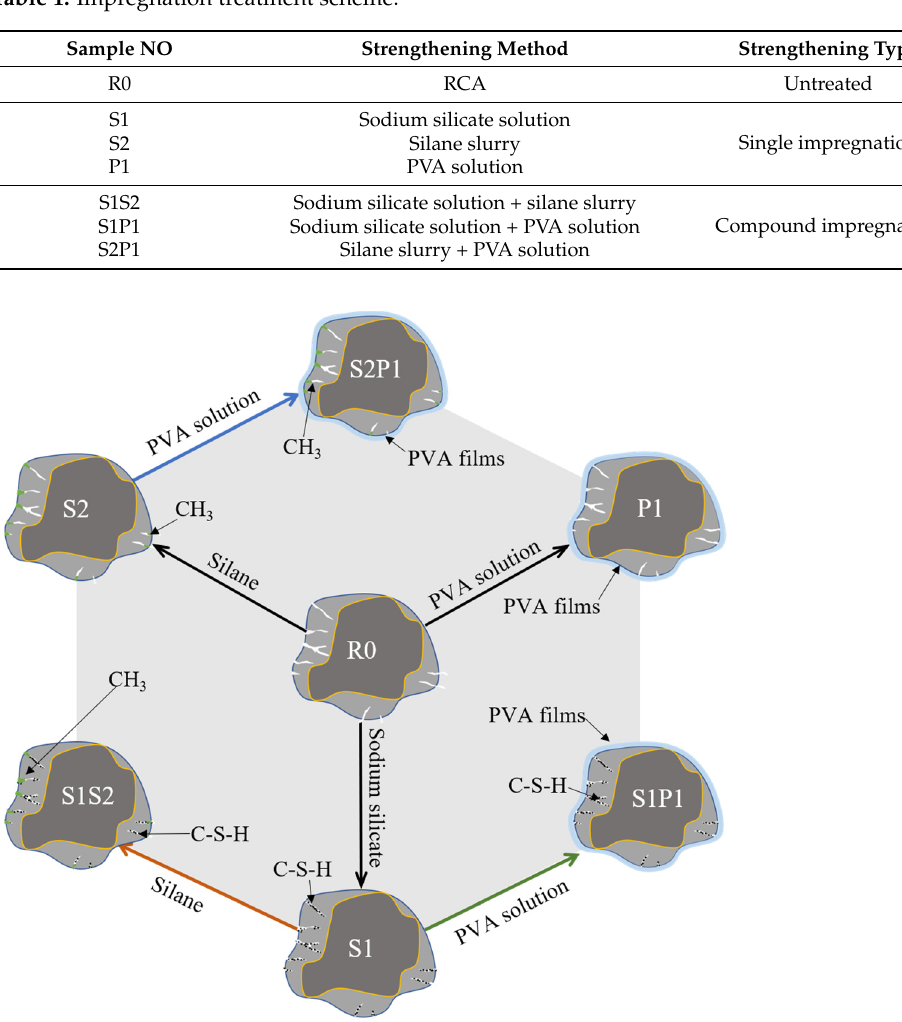
Figure 3. The strengthening principle.